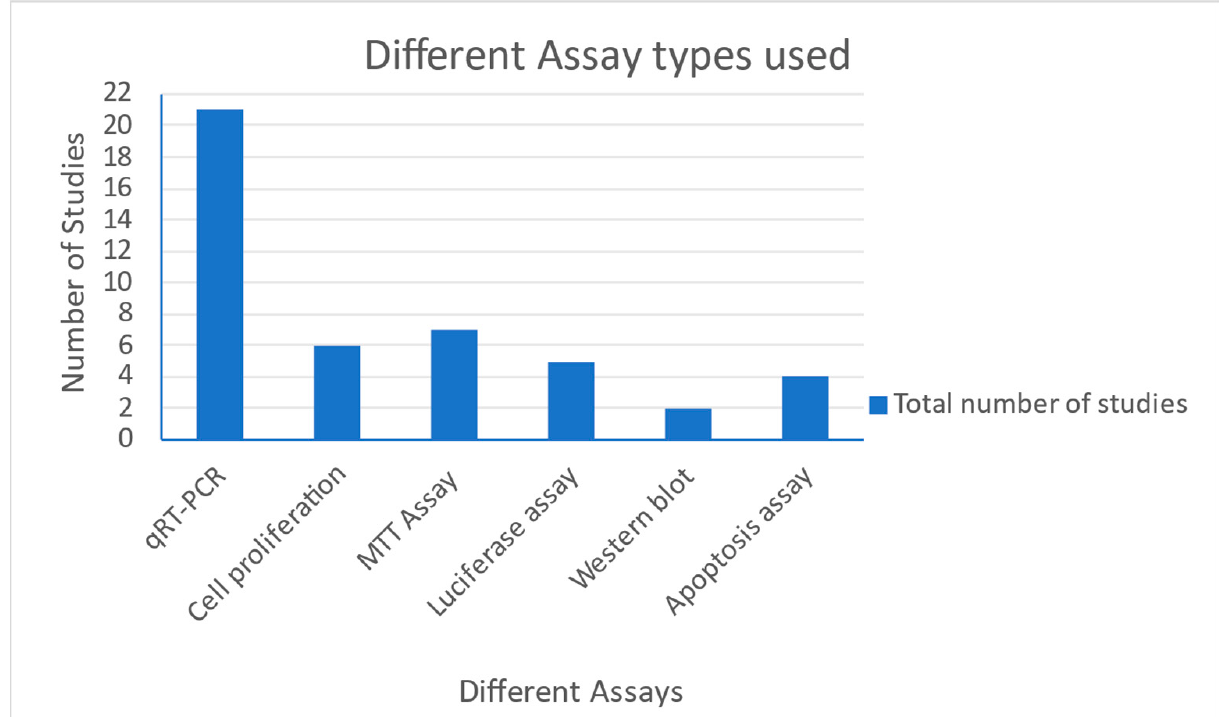
Figure 2. Chart showing the various assays performed in the collected studies.